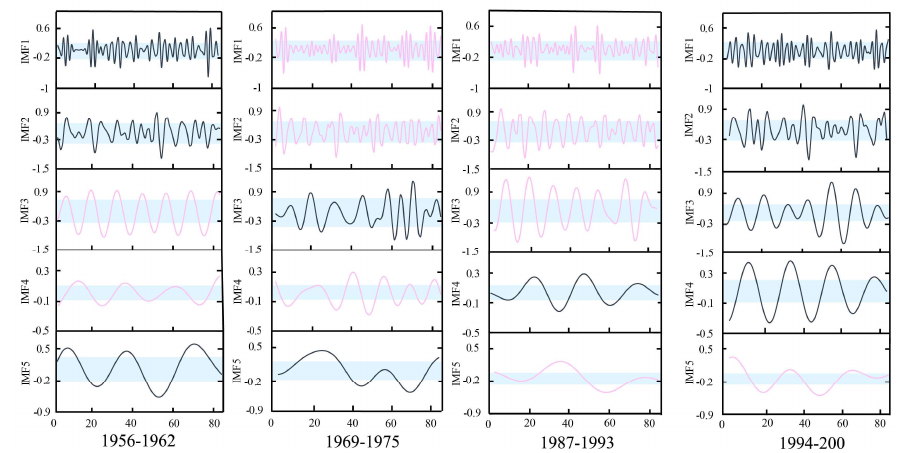
Figure 11. Similarity of segmented IMFs at Xianyang gauge. The pink lines in segments represent similar IMFs detected by the K-S test, and the blue areas demonstrate change intervals of 25%–75%.